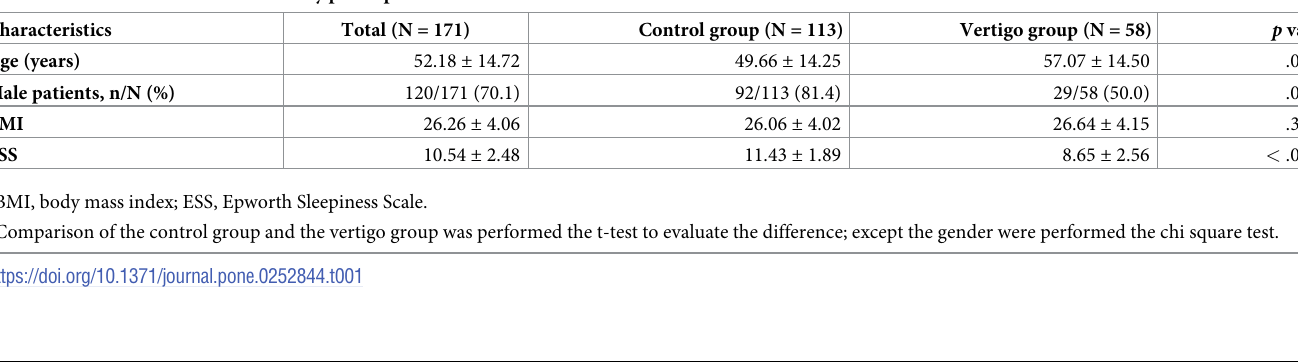
Table 1. Baseline characteristics of study